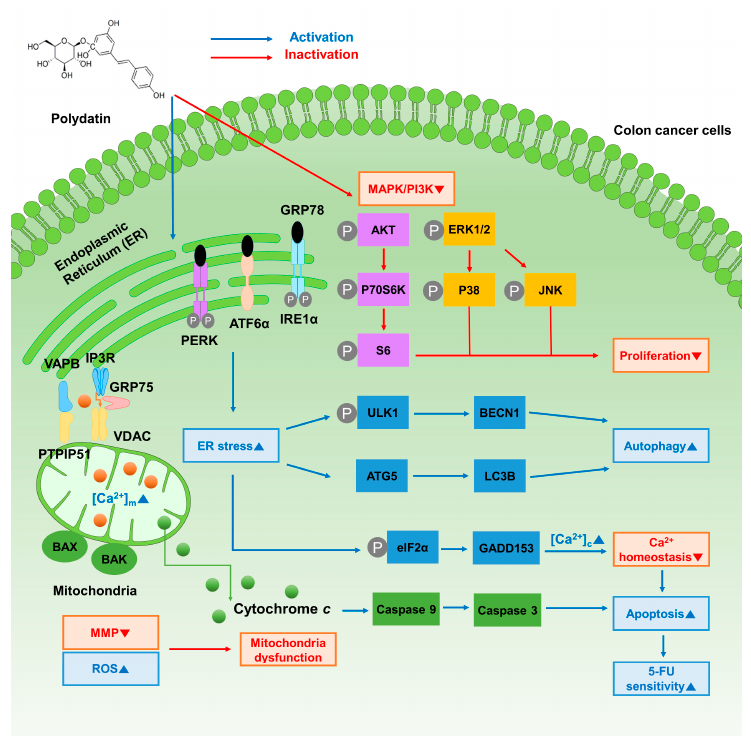
Figure 8. Schematic illustration of polydatin on colon cancer cells.